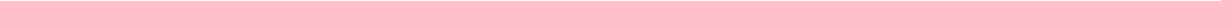
Fig. 2 Tbx3 is required for proliferation of IFE basal cells and abdominal skin expansion during pregnancy. a qPCR analysis of Tbx3 gene expression in dorsal and ventral skin from virgin and pregnant (8 – 16 dpc) mice. Data represent the mean ± s.e.m. ( n = 3 mice); * P < 0.05, ** P < 0.01, analysed by Dunnett ’ s multiple comparison test. b Immuno fl uoresence of Tbx3 ( green ) and Hoechst ( blue ) on ventral skin from virgin and 16 dpc mice. c Quanti fi cation of Tbx3 + cells in IFE basal layers. d , f Immuno fl uoresence of Tbx3 ( d ) or Ki67 ( f ) ( green ) and Hoechst ( blue ) on tamoxifen-treated dorsal and ventral skin of 16 dpc control ( Tbx3 fl ox/ fl ox /WT ) and Tbx3 cKO ( Tbx3 fl ox/ fl ox /K14-CreER ) mice interbred with genetically unaltered males. e , g Quanti fi cation of Tbx3 + cells ( e ) and Ki67 + cells ( g ) in IFE basal layers of dorsal and ventral skin from 16 dpc mice. h Representative images of 16 dpc control and Tbx3 cKO mice. An arrow indicates a swollen fl ank. i Representative images of razor-cut abdominal skin of 16 dpc control and Tbx3 cKO mice. The skin was laterally cut with a razor at 1.5 cm in length. Arrows indicate the wound width. j Quanti fi cation of the wound width. k Thickness of keratin 10 + layers of ventral skin from 16 dpc control and Tbx3 cKO mice. l IFE basal cell density in ventral skin from 16 dpc control and Tbx3 cKO mice. m Immuno fl uoresence of α 18-catenin ( green ) and Hoechst ( blue ) on ventral skin from 16 dpc control and Tbx3 cKO mice. c , g Data represent the mean ± s.e.m. of averages of three independent experiments ( n = 3). > 500 cells ( c ), > 220 cells ( e ), > 200 cells ( g ) were analysed to calculate the average in each experiment; ** P < 0.01, *** P < 0.001, analysed by the two-tailed t -test ( c ), Dunnett ’ s multiple comparison test ( e ) or Tukey ’ s multiple comparison test ( g ). j – l Data represent the mean ± s.e.m. ( n = 3 mice); * P < 0.05, ** P < 0.01, analysed by the two-tailed t -test. b , m White-dotted lines indicate basement membranes. Experiments were repeated three times with three mice for representative images in ( b , d , f , h , i , m